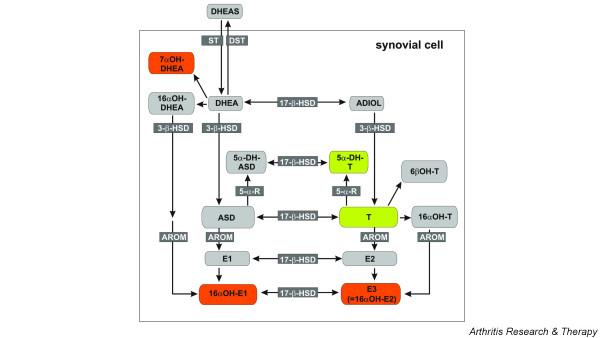
Complexity of androgen conversion in peripheral cells. DHEAS, DHEA, and ASD are the major androgen precursors, which are released from the adrenal gland (particularly relevant in postmenopausal women). These androgens enter the peripheral cell to be converted to downstream metabolites using diverse enzyme pathways. 3β-HSD, 3β-hydroxysteroid dehydrogenase (converts delta 5 androgens into delta 4 androgens); 5α-DH, 5α-dihydro; 5-α-R, 5α-reductase; 17β-HSD, 17β-hydroxysteroid dehydrogenase; ADIOL, androstenediol; ASD, androstenedione; AROM, aromatase; DHEA, dehydroepiandrosterone; DHEAS, DHEA sulfate; DST, DHEA sulfotransferase; E1, estrone; E2, 17β-estradiol; E3, 16α-hydroxylated E2 (also known as estriol); OH, hydroxyl group at the indicated position; ST, sulfatase; T, testosterone.